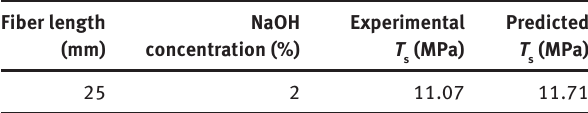
Table 4 Validation of design